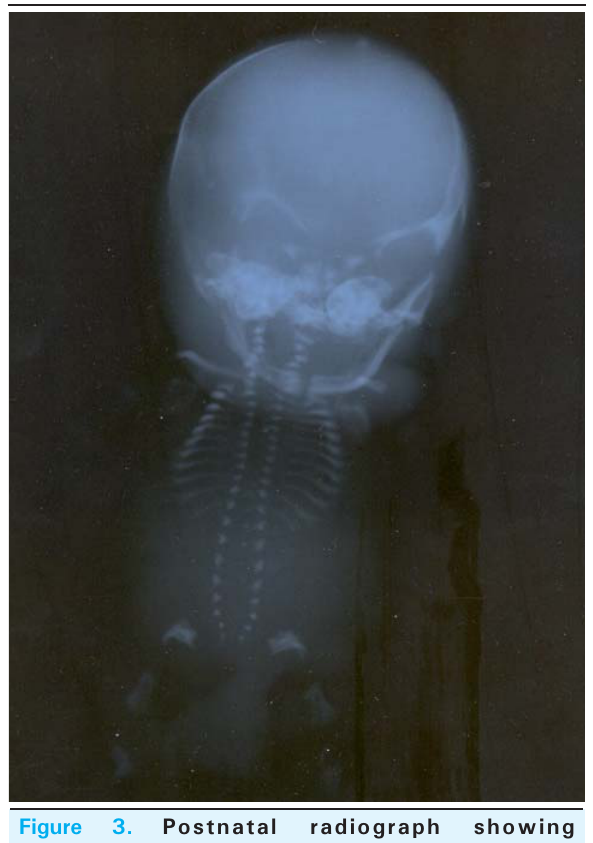
Figure 3. Postnatal radiograph